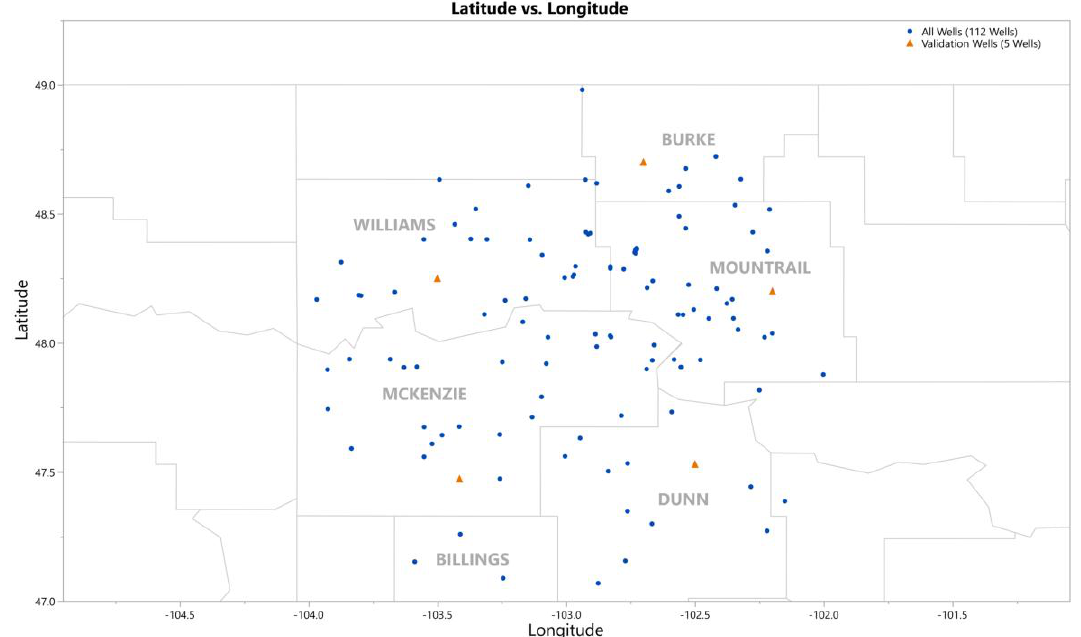
Figure 12. Distribution of all 112 wells and an additional 5 validation wells.